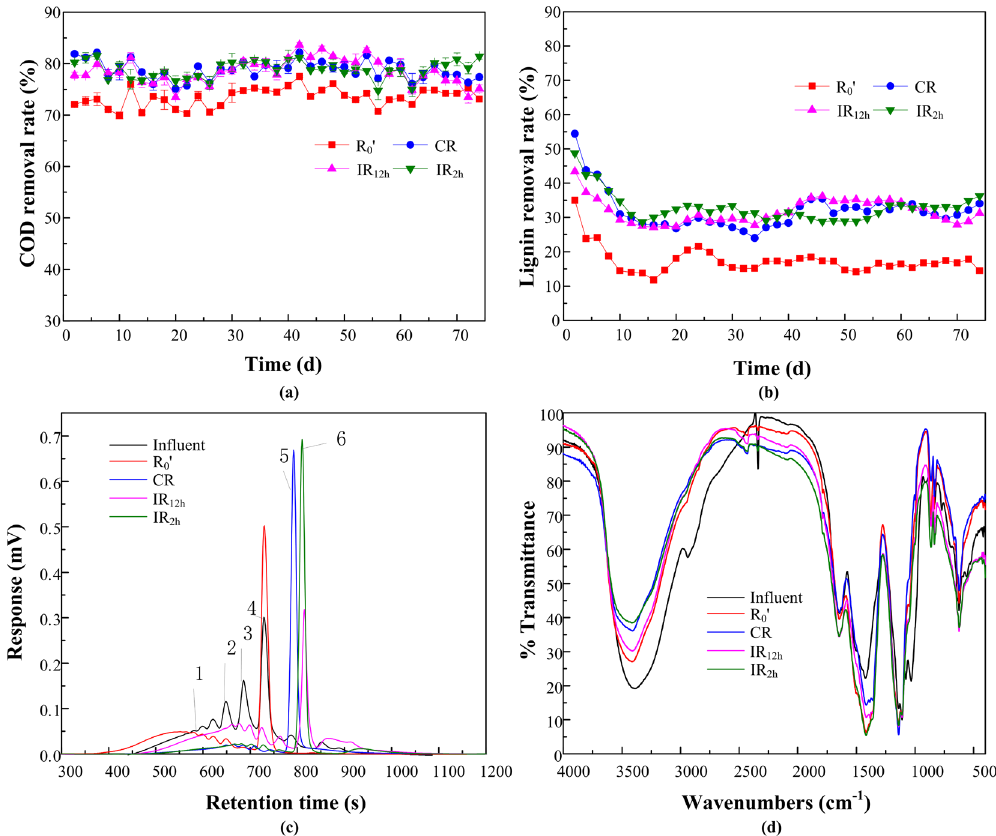
Figure 1. Reactor performances under different DC application modes. ( a ) COD removal rate; ( b ) Lignin removal rate; ( c ) Apparent molecular weight (AMW) distribution; ( d ) FTIR